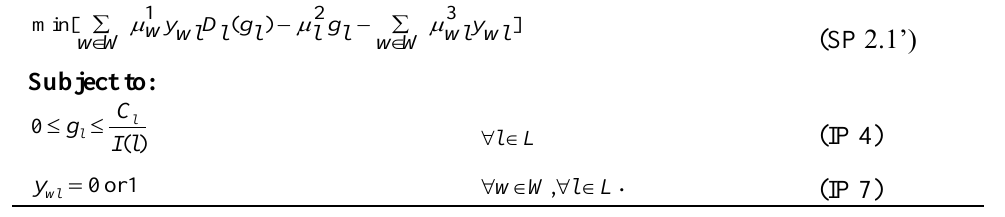
Table A1. Algorithm for solving problem (SP